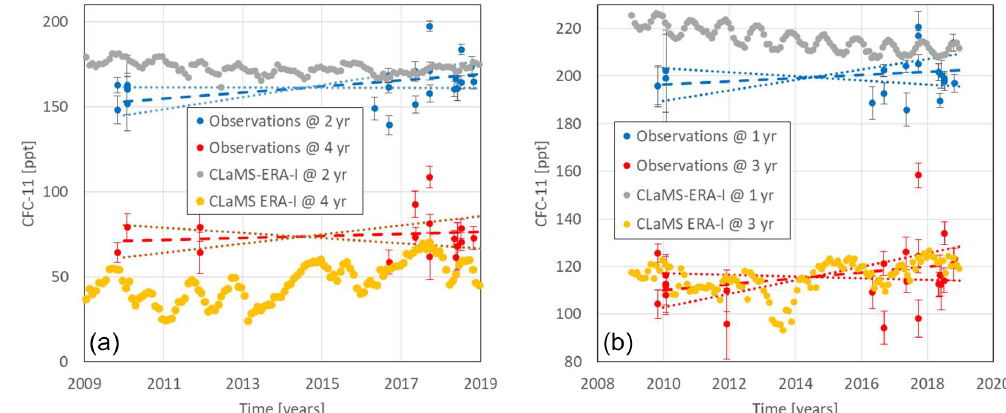
Figure 3. Panel (a) shows a comparison of observation-based CFC-11 mixing ratio trends at mean ages of air of 2 (blue), and 4 (red) years with those from the CLaMS model run driven by the ERA-Interim reanalysis (grey and yellow) in the northern hemispheric stratosphere. The latter have been derived as averages between 30 and 90 ◦ N. The dashed and dotted lines correspond to regression lines (weighted by their 1 σ standard error for observations) and an illustration of their 2 σ uncertainties over the time periods displayed. Panel (b) shows the same comparison but at mean ages of 1 and 3 years. The numerical values can be found in Table